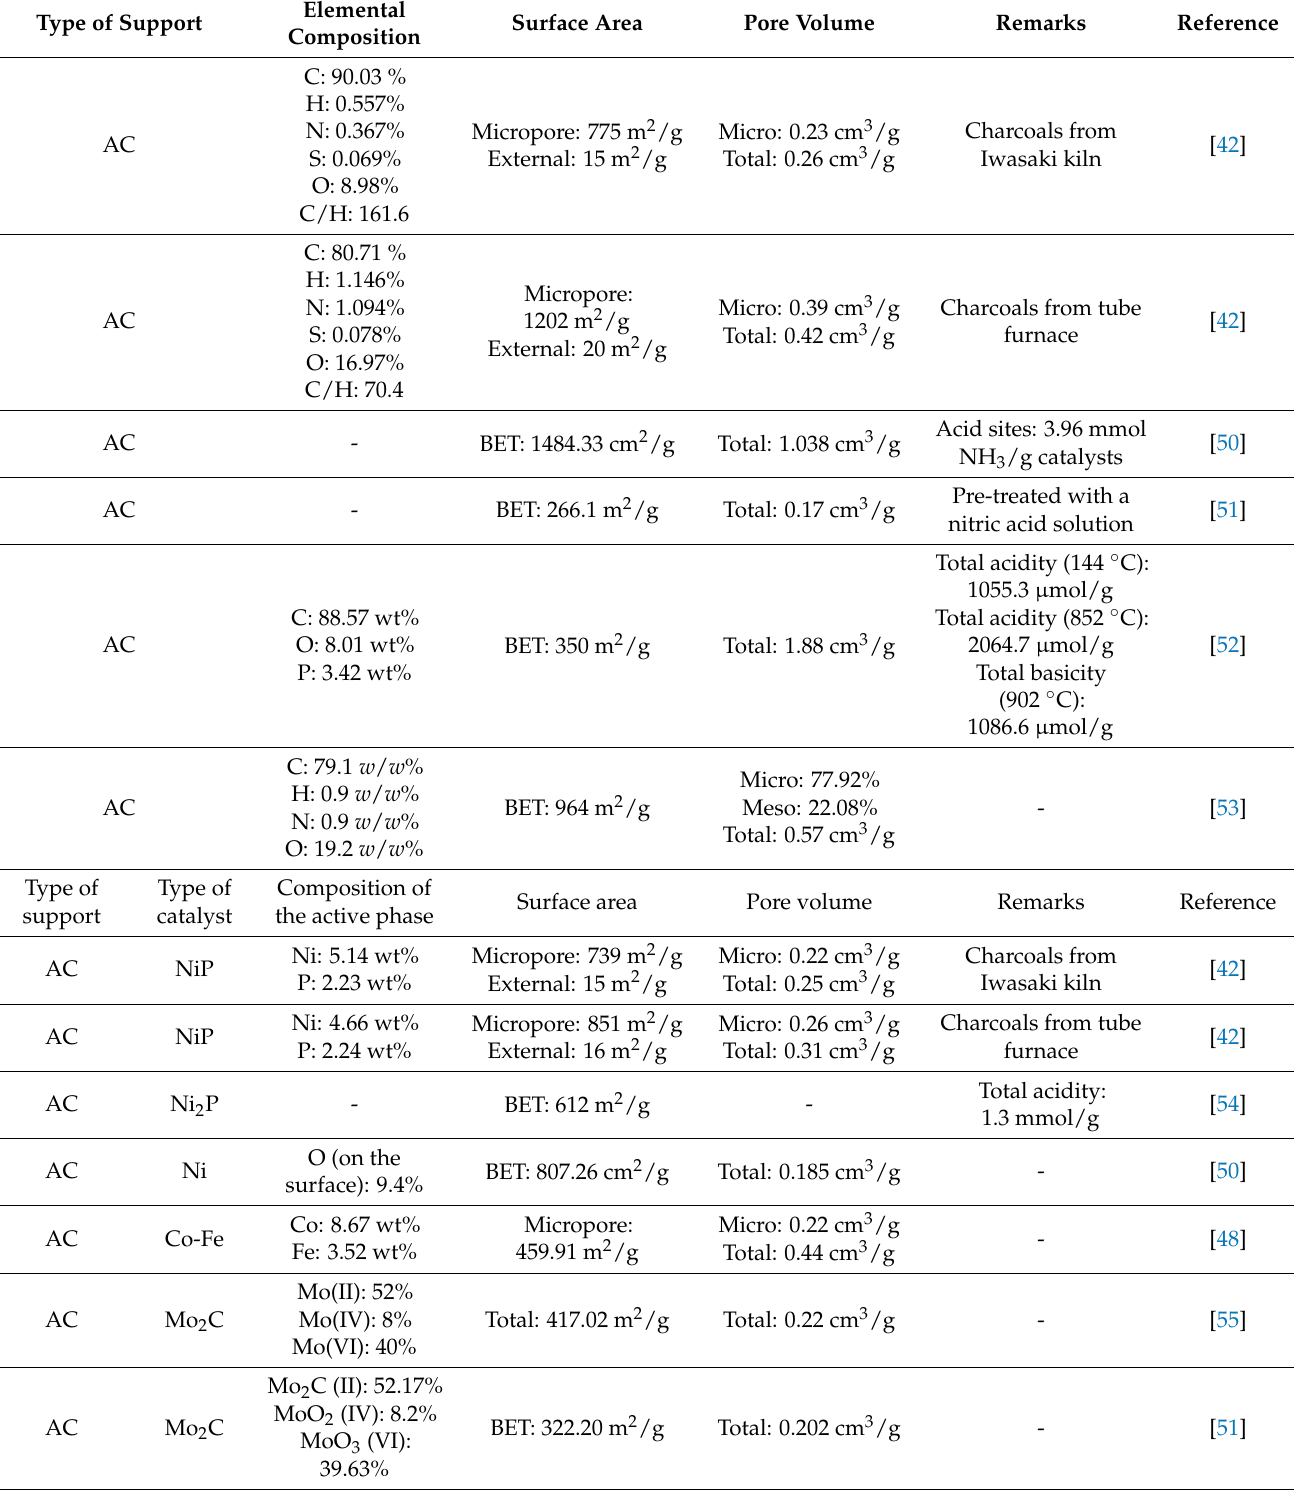
Table 2. AC as catalyst support for renewable diesel